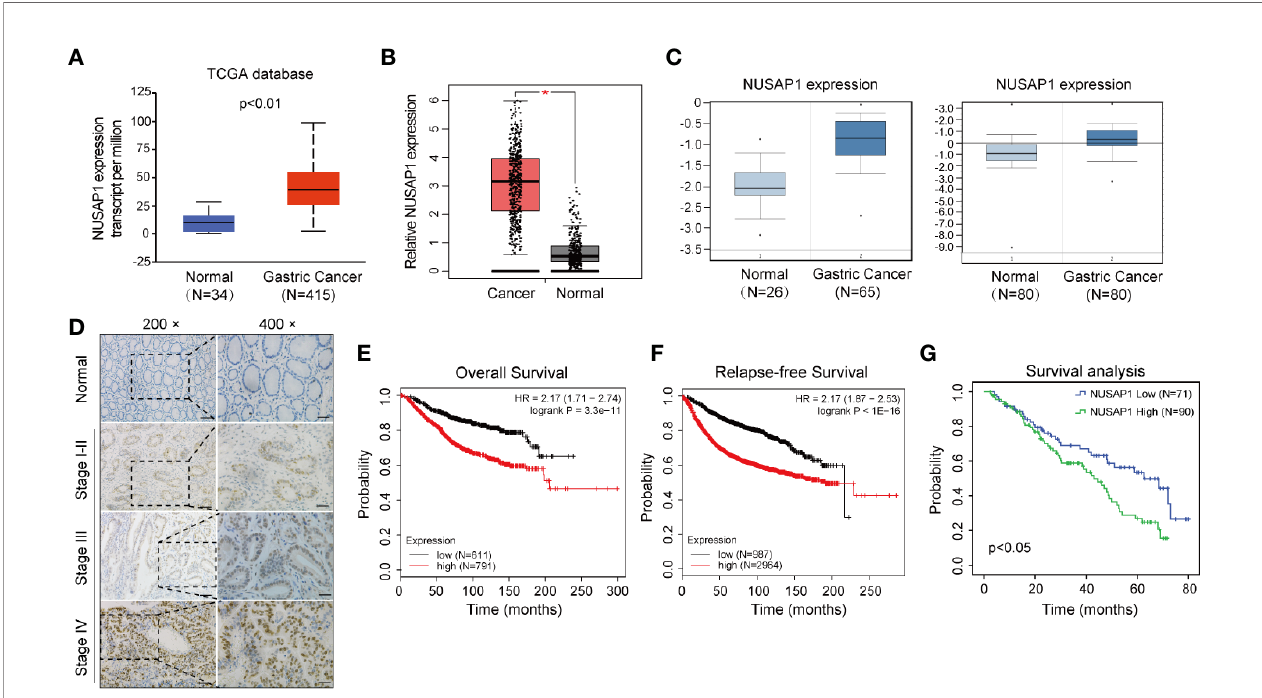
FIGURE 2 | NUSAP1 is upregulated in GC and predicts disease progression and poor prognosis. (A, B) Analysis of the relative mRNA expression of NUSAP1 in the TCGA and GEPIA database (Student ’ s t test, * p <0.05). (C) The expression pro fi le of NUSAP1 in GC and normal tissues was searched in the Oncomine Gene Browser (Student ’ s t test, p <0.05). (D) Representative images of IHC staining of NUSAP1 in human GC tissues and non-neoplastic tissue samples. Scale bars represent 50 m M or 25 m M. (E) The correlation between NUSAP1 expression and overall survival in patients with GC obtained from Kaplan – Meier Plotter databases (log-rank test, p <0.01). (F) The correlation between NUSAP1 expression and relapse-free survival (RFS) in patients with GC obtained from Kaplan – Meier Plotter databases (log-rank test, p <0.01). (G) Kaplan – Meier survival analysis performed with survival data of gastric patients with high NUSAP1 expression ( n =90) versus low NUSAP1 expression ( n =71), Log-rank test, p ef fi ciency of our shRNAs and NUSAP1 expression constructs ( Figure 3A and Supplementary Figure S3A ). Growth curves obtained from the CCK-8 assay revealed that NUSAP1